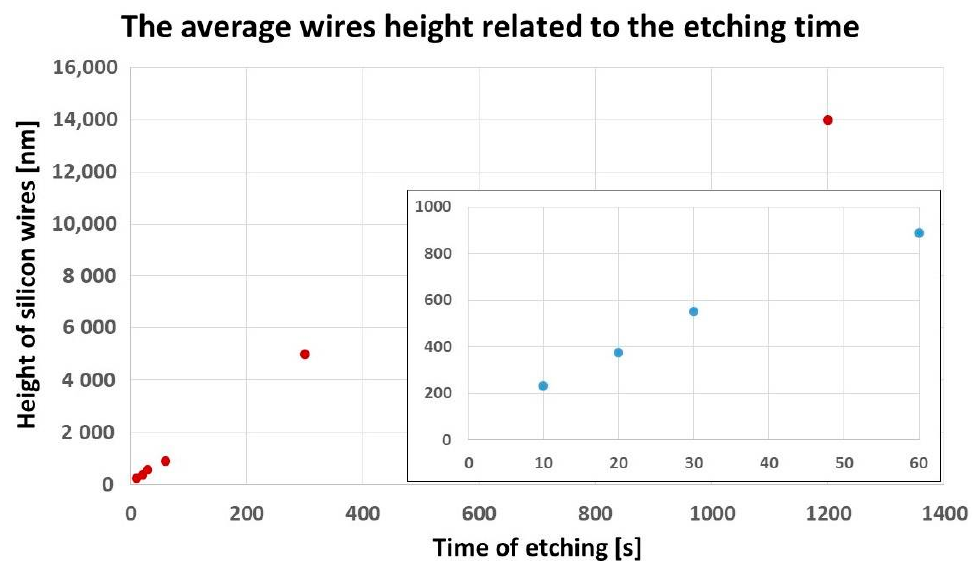
Figure 4. The graph of average wire height in relation to the etching time.